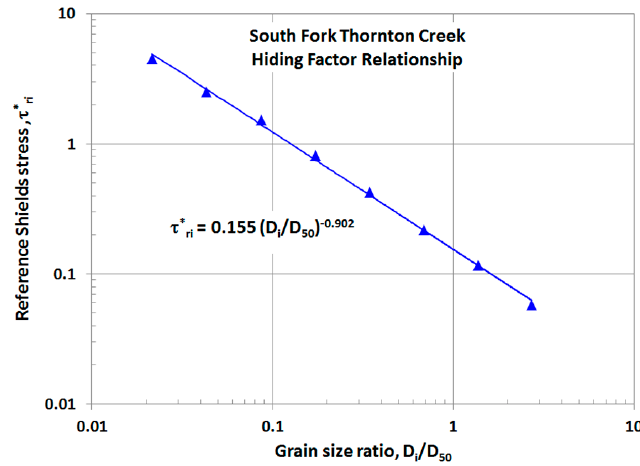
Figure 2. Hiding factor equation. Reference Shields stress, (cid:2028) (cid:3045)(cid:3036)∗ , for each grain size, determined from the intersection of the regression lines shown in Figure 1 with (cid:1849) (cid:3036)∗ = 0.002, are plotted against the grain size ratio D i /D 50 to obtain the hiding factor relationship. Here, D 50 refers to the subsurface layer. (cid:2028) (cid:3045)(cid:2873)(cid:2868)∗ is found to be 0.155, and the exponent is 0.902.